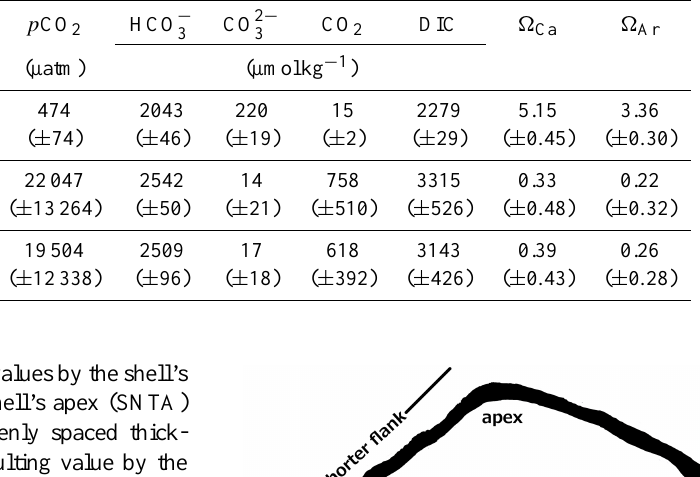
and CO 2 − ions, CO 2 concentration in 3 3